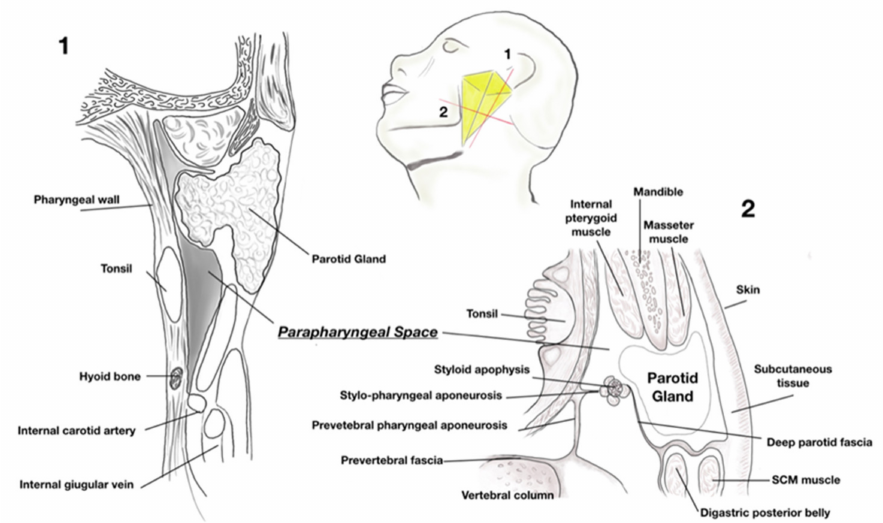
Figure 2. Parapharyngeal space anatomy. Yellow box: representation of pyramid shaped parapha- ryngeal space. 1 : sagittal section view. 2 : cross section